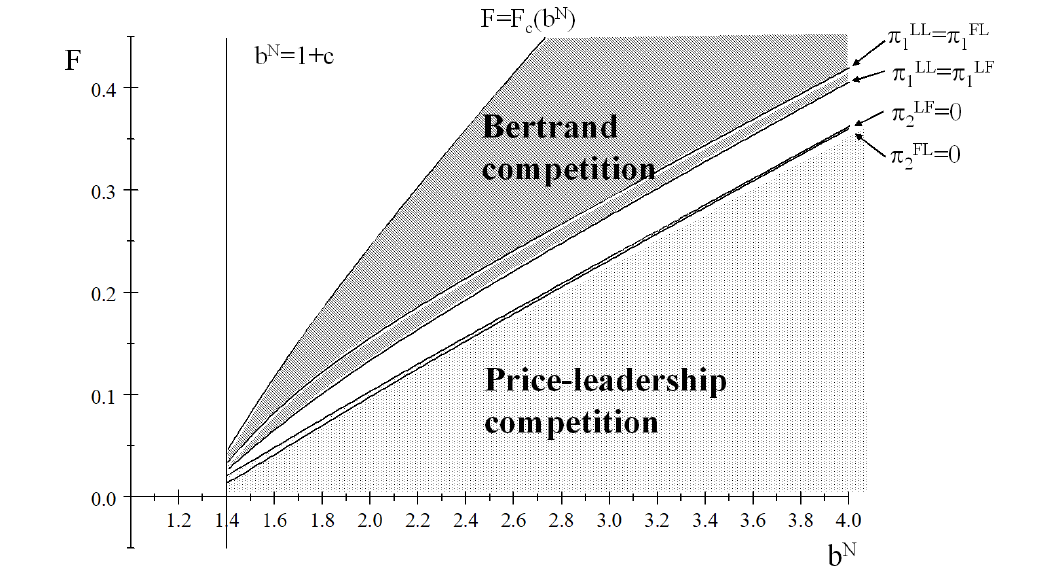
Figure 1. The type of competition in case of c =